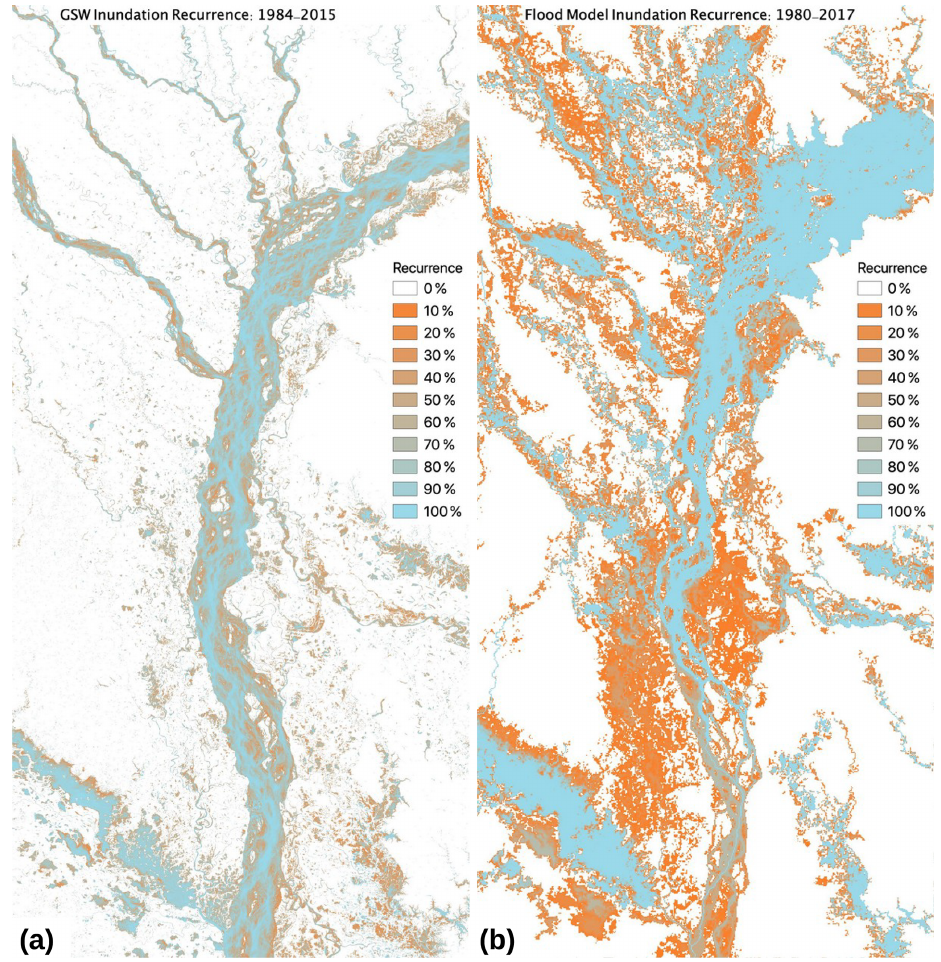
Figure 10. Recurrence (percentage of years) of maximum flood inundation for the GSW data set (a) and the flood model forced by MSWEPp1deg precipitation (b) . Model results show flood inundation greater than 0.5m, over the period 1980–2017, with nine simula- tions run for each year, generated from runoff simulations with differing FUSE